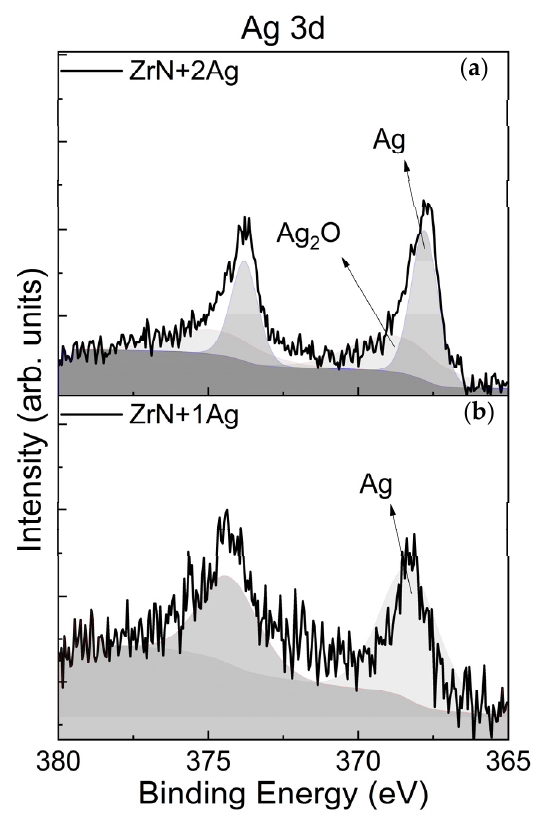
Figure 3. XPS spectra of Ag 3d for the ( a ) ZrN+2Ag and ( b ) ZrN+1Ag coatings.